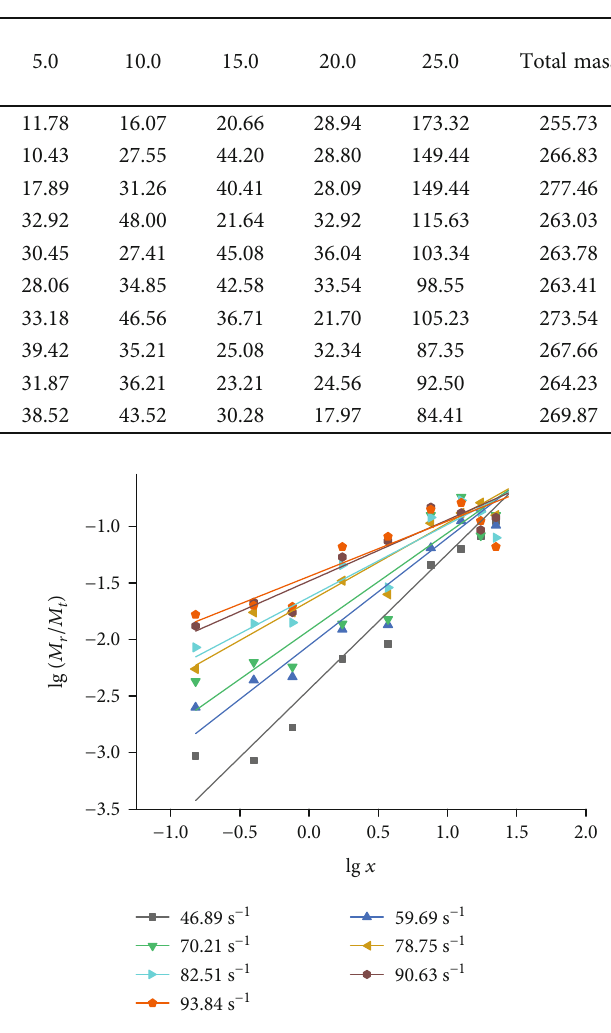
Figure 6: Curves for the distribution of fractional bulkiness of pomegranate biotite